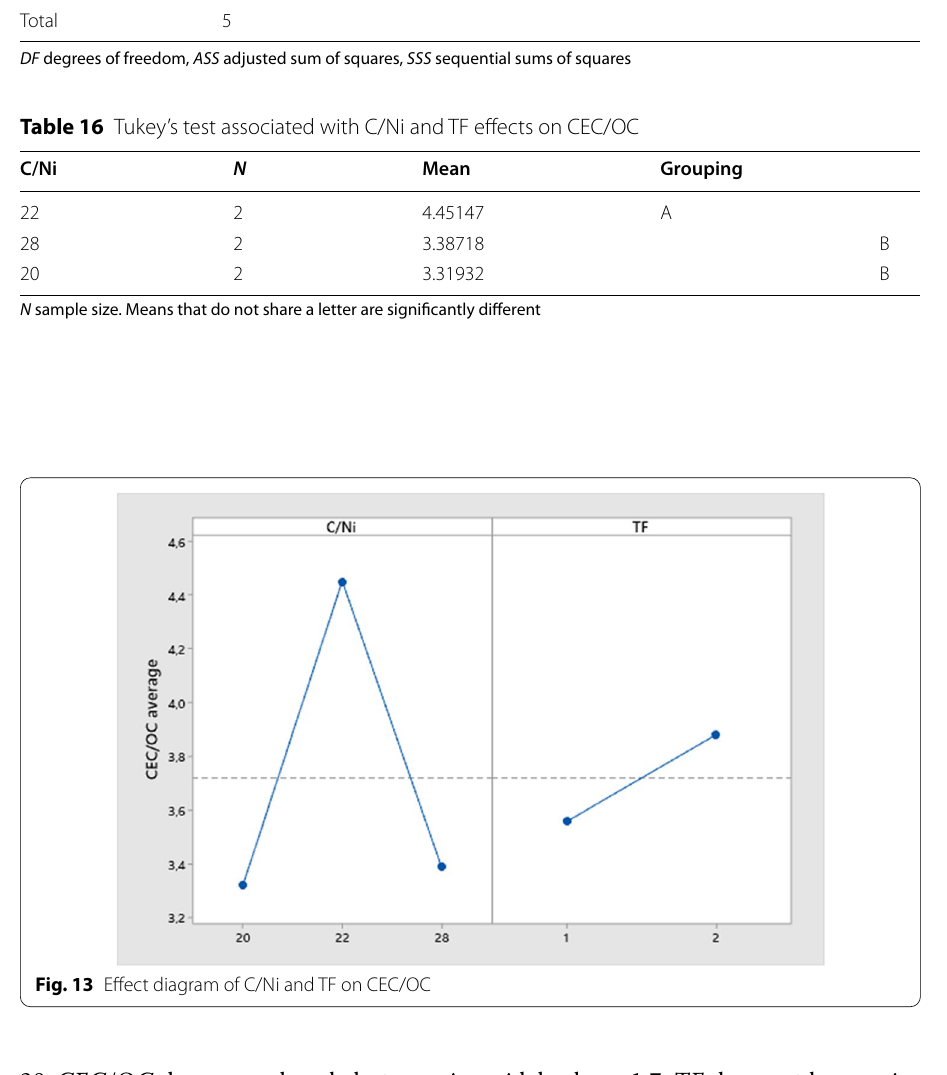
DF degrees of freedom, ASS adjusted sum of squares, SSS sequential sums of squares Table 16 Tukey’s test associated with C/Ni and TF effects on CEC/OC